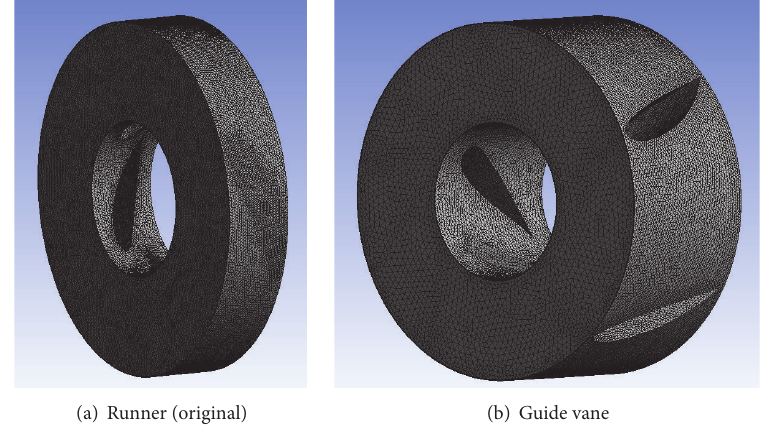
Figure 7: Computational grids.